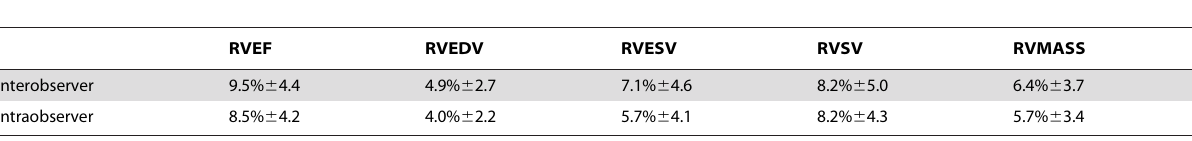
Table 4. Interobserver and intraobserver variability of RV functional